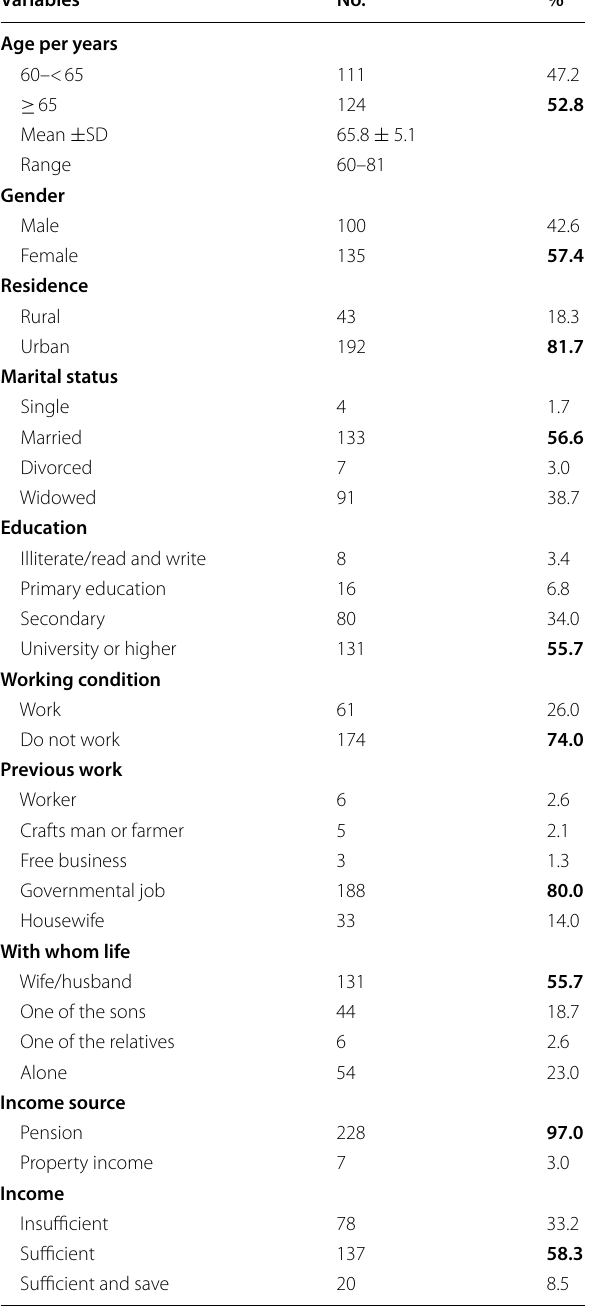
Table 1 Socio-demographic characteristics of studied elderly